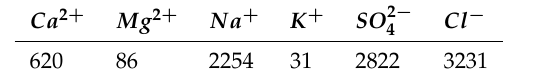
Table 1. Chemical composition (in mg/L) of Segdoud brine (March 1995) taken from [42].